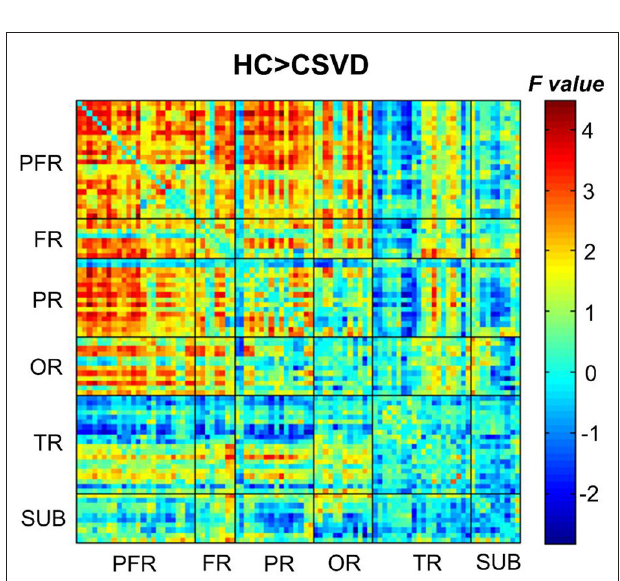
FIGURE 4 | Comparison of the DFC strengths between CSVD patients and HCs (HCs > CSVD) (NBS correction, edge P < 0.001, component P < 0.05, 1,000 iterations). NBS, network-based